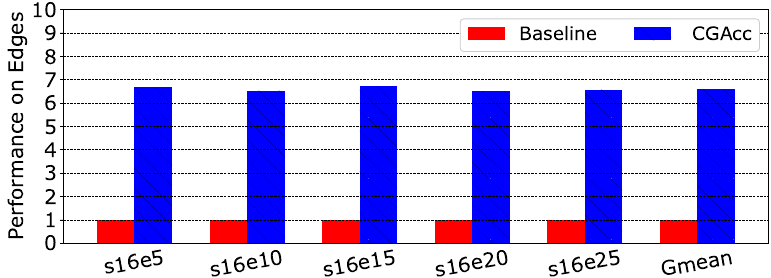
Figure 17. Comparison of performance between the baseline and CGAcc on edges.